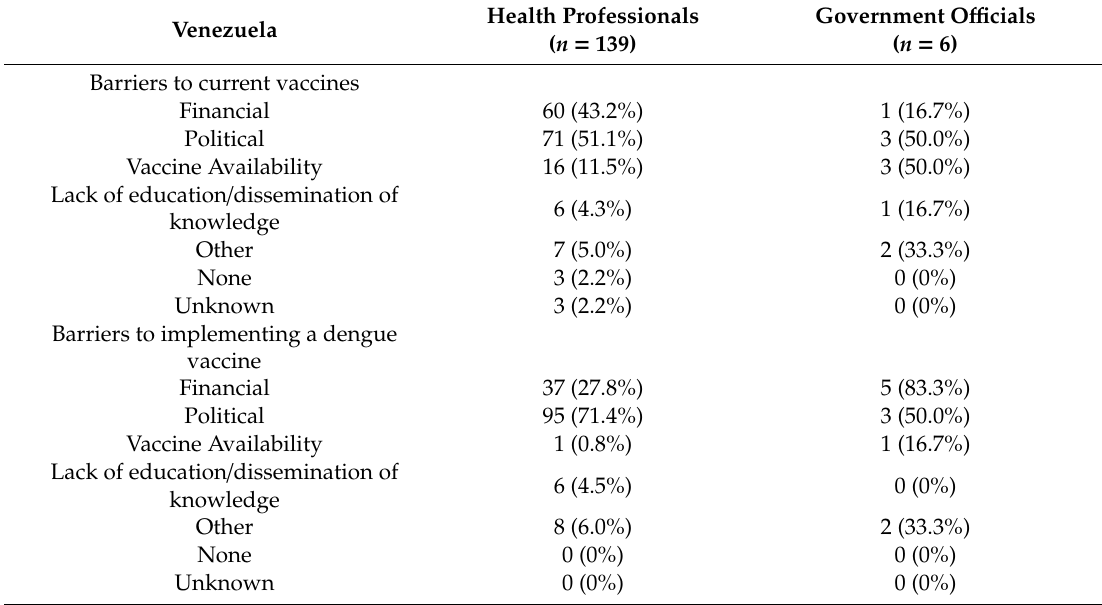
Table 6. Self-reported barriers to currently providing mandated vaccines and to implementing the dengue vaccine in Venezuela. Free responses were then coded into the categories